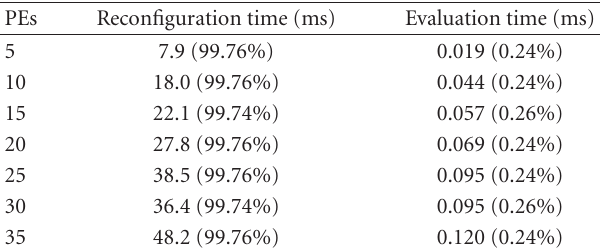
Table 3: The specialization overhead, split up in reconfiguration time and evaluation time.